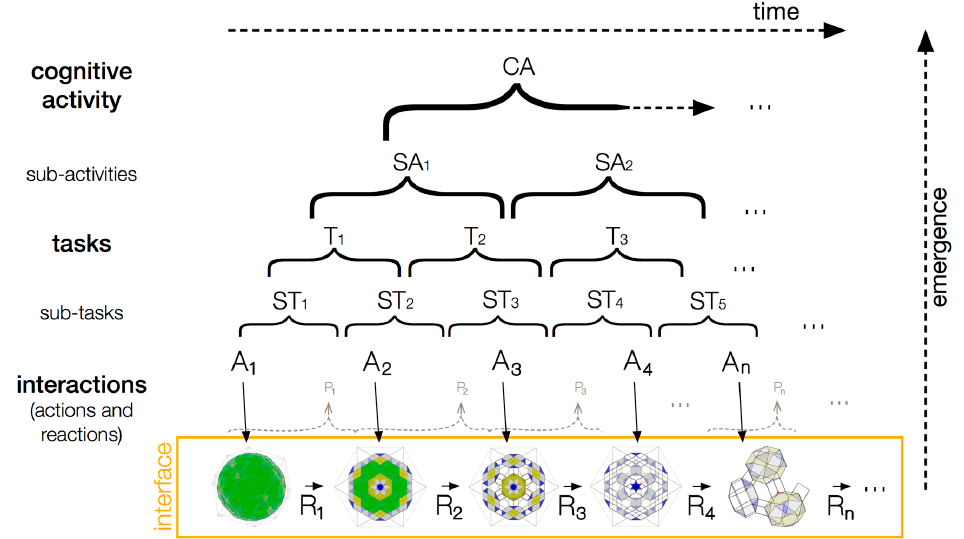
Figure 1. A generic complex cognitive activity. Top-down view: Activity comprises sub-activities, tasks, sub-tasks, and individual interactions. Bottom-up view: Activity emerges over time, through performance of interactions and tasks. Adapted from [39].